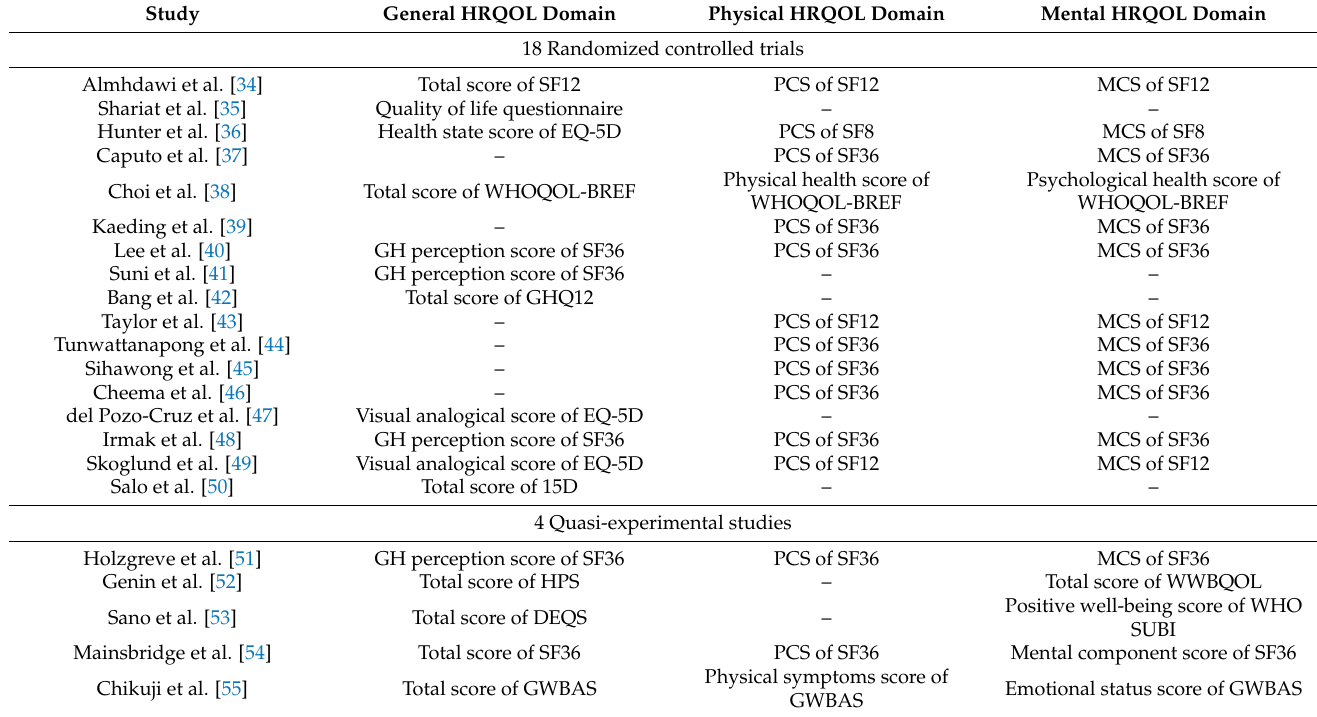
Table A2. Classification of quantitative HRQOL